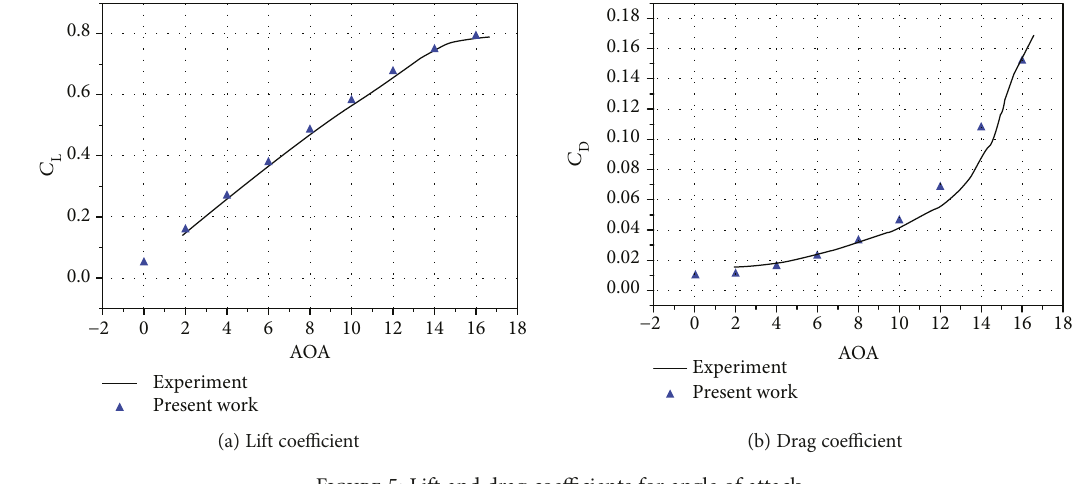
Figure 5: Lift and drag coe ffi cients for angle of